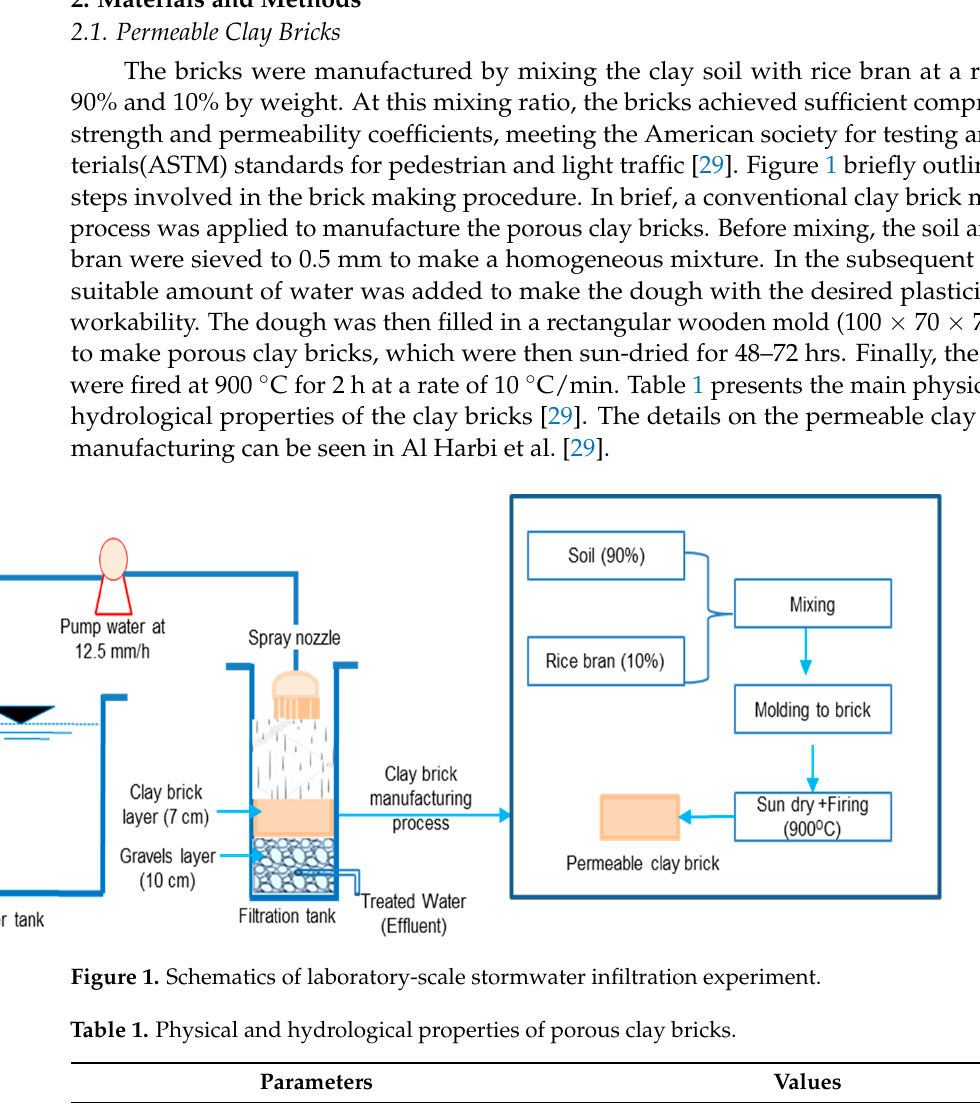
Table 1. Physical and hydrological properties of porous clay bricks.